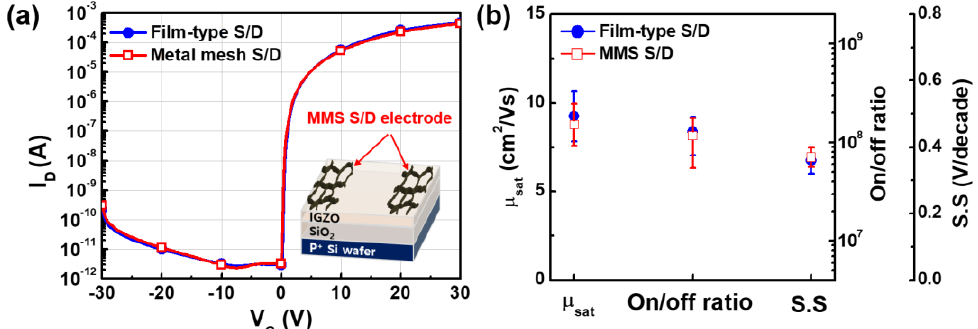
Figure 5. ( a ) Transfer characteristics; and ( b ) electrical parameters of In-Ga-Zn-O (IGZO) TFTs using conventional film-type or MMS source/drain (S/D) electrodes with error bars.